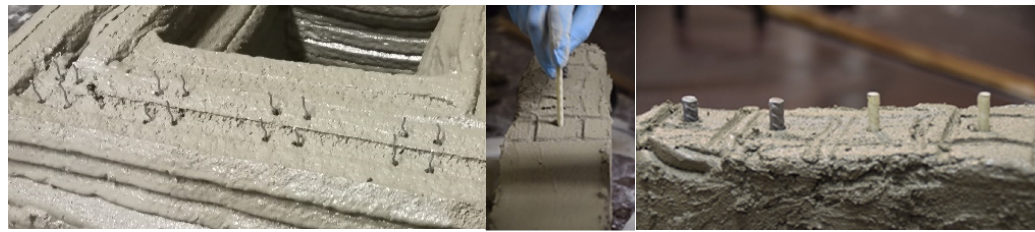
Figure 3. Vertical insertion of reinforcement: wire fibers ( left ), rebars ( middle and right ).